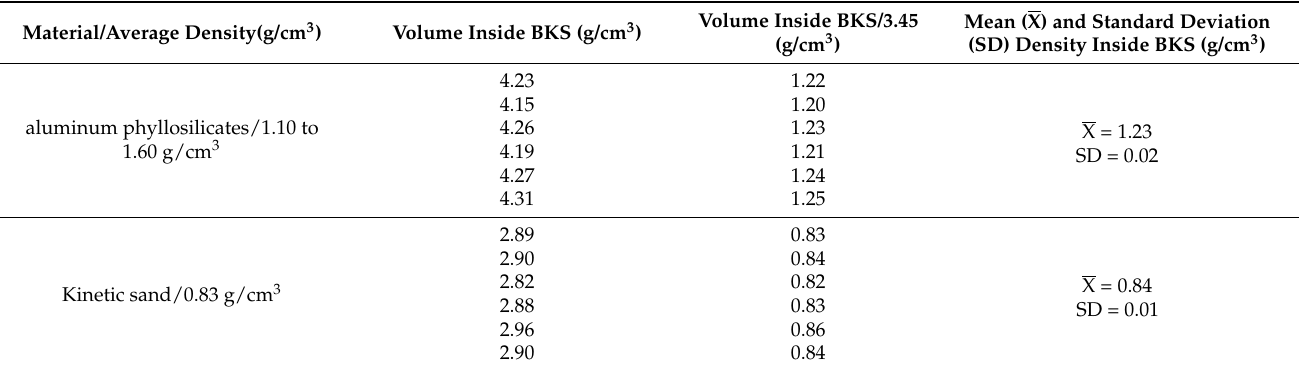
Table 2. Compacting factor analysis in two different materials to test and validate the mathematical proof of concept of the BKS device.